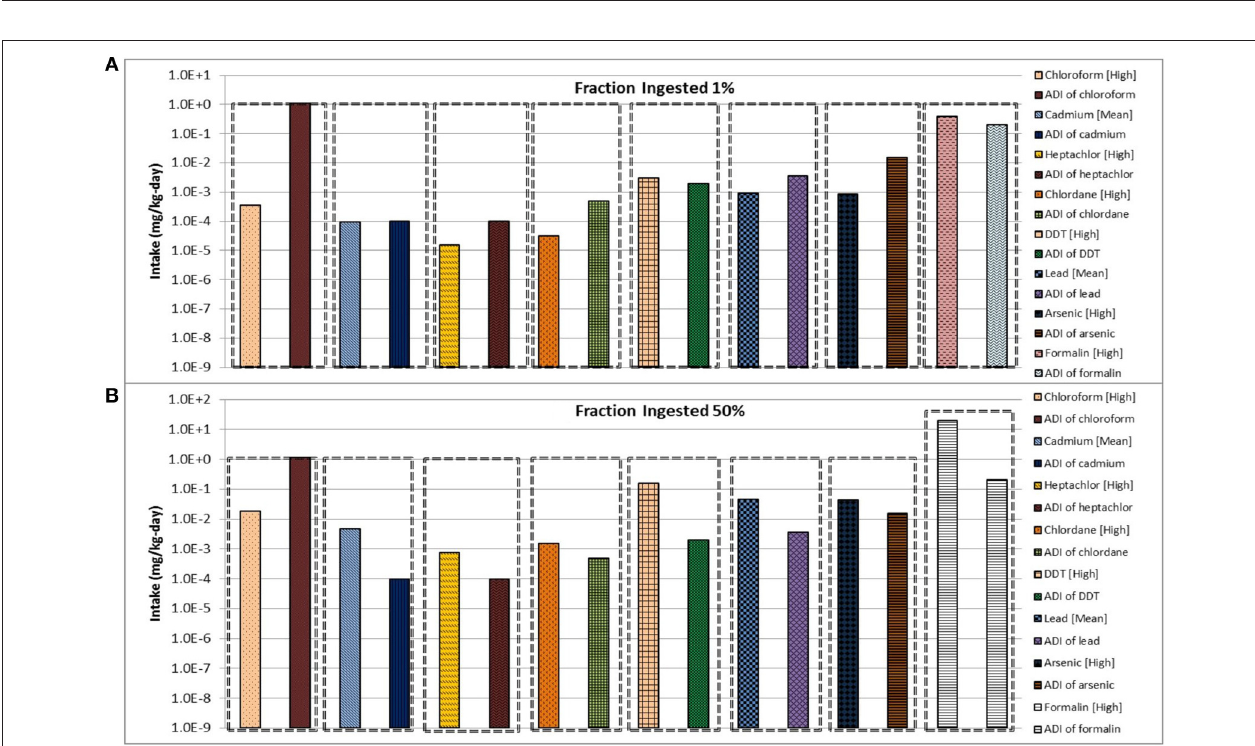
FIGURE 7 | Intake of different contaminants/adulterants via food ingestion for (A) 1% and (B) 50% of the adulterated food ingested for